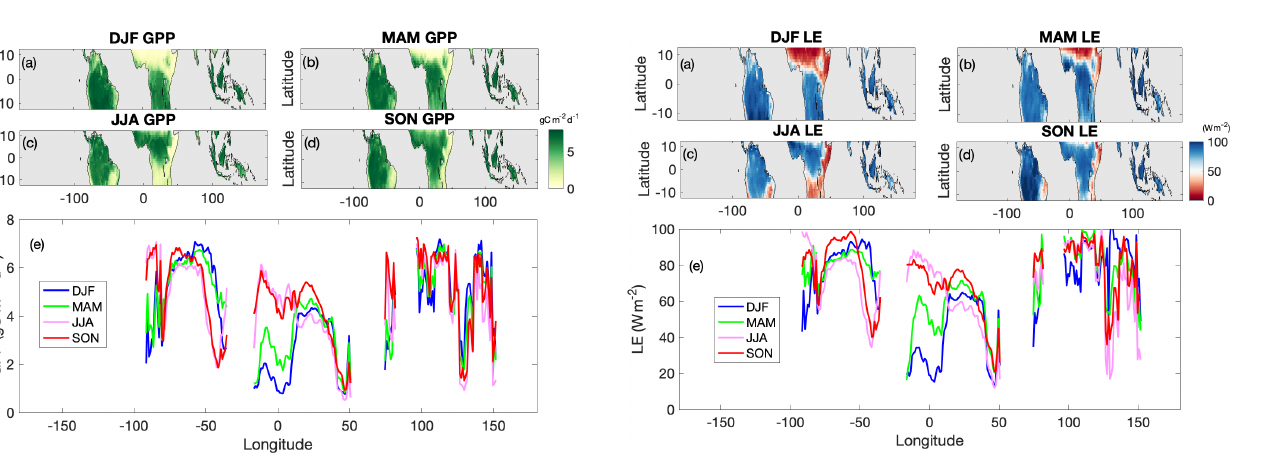
Figure 5. Same as Fig. 4 but for gross primary production (GPP). Figure 6. Same as Fig. 4 but for latent heat flux